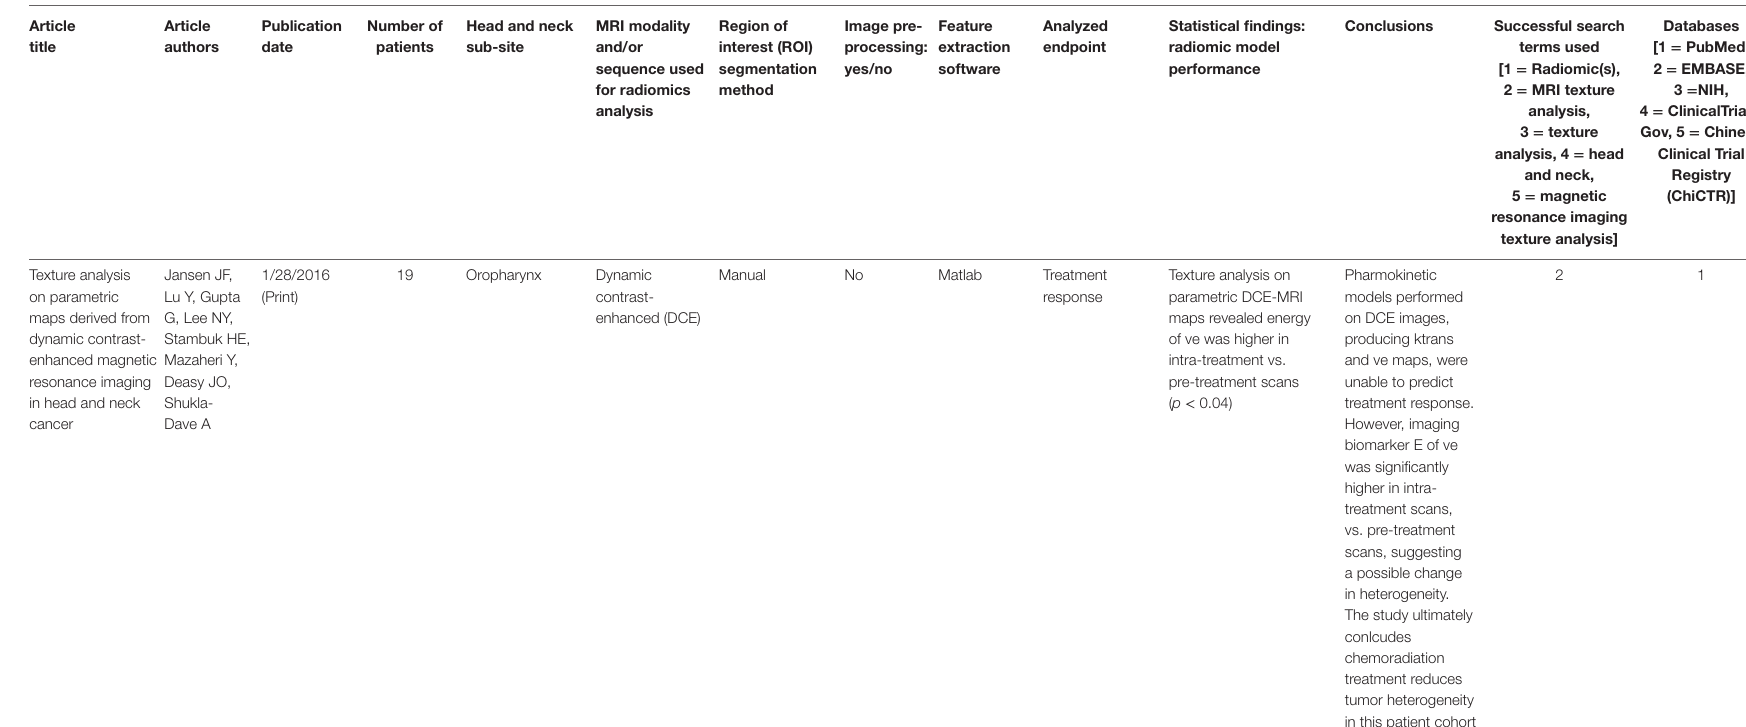
Treatment response